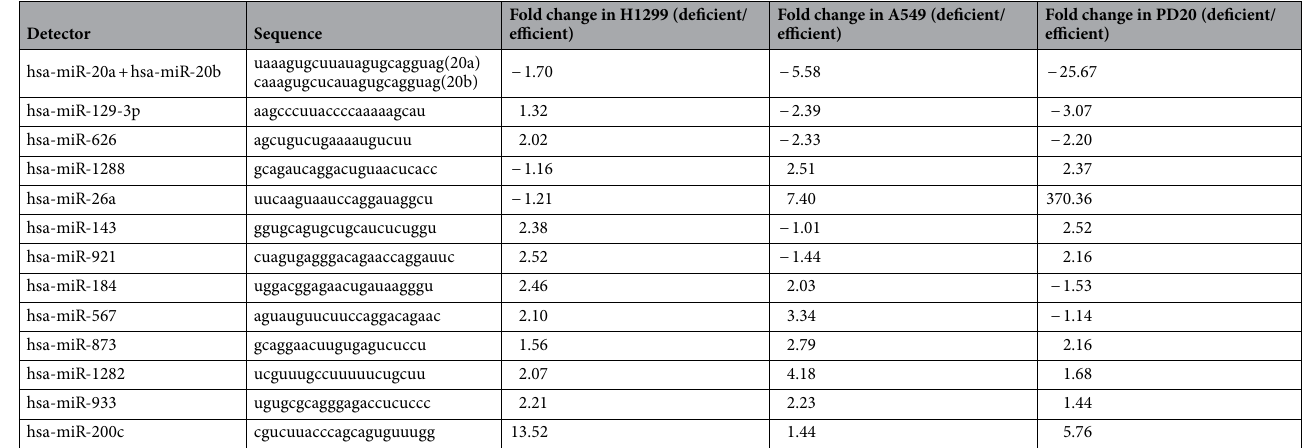
Table 1. miRNAs expression in Fanconi anemia pathway deficient cells.